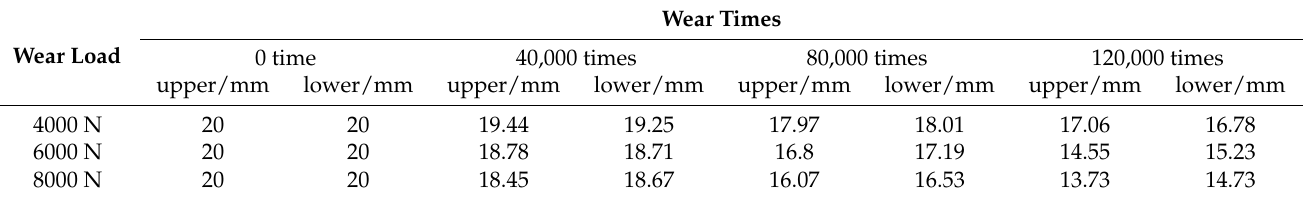
Table 3. Wear test results of upper and lower U-shaped